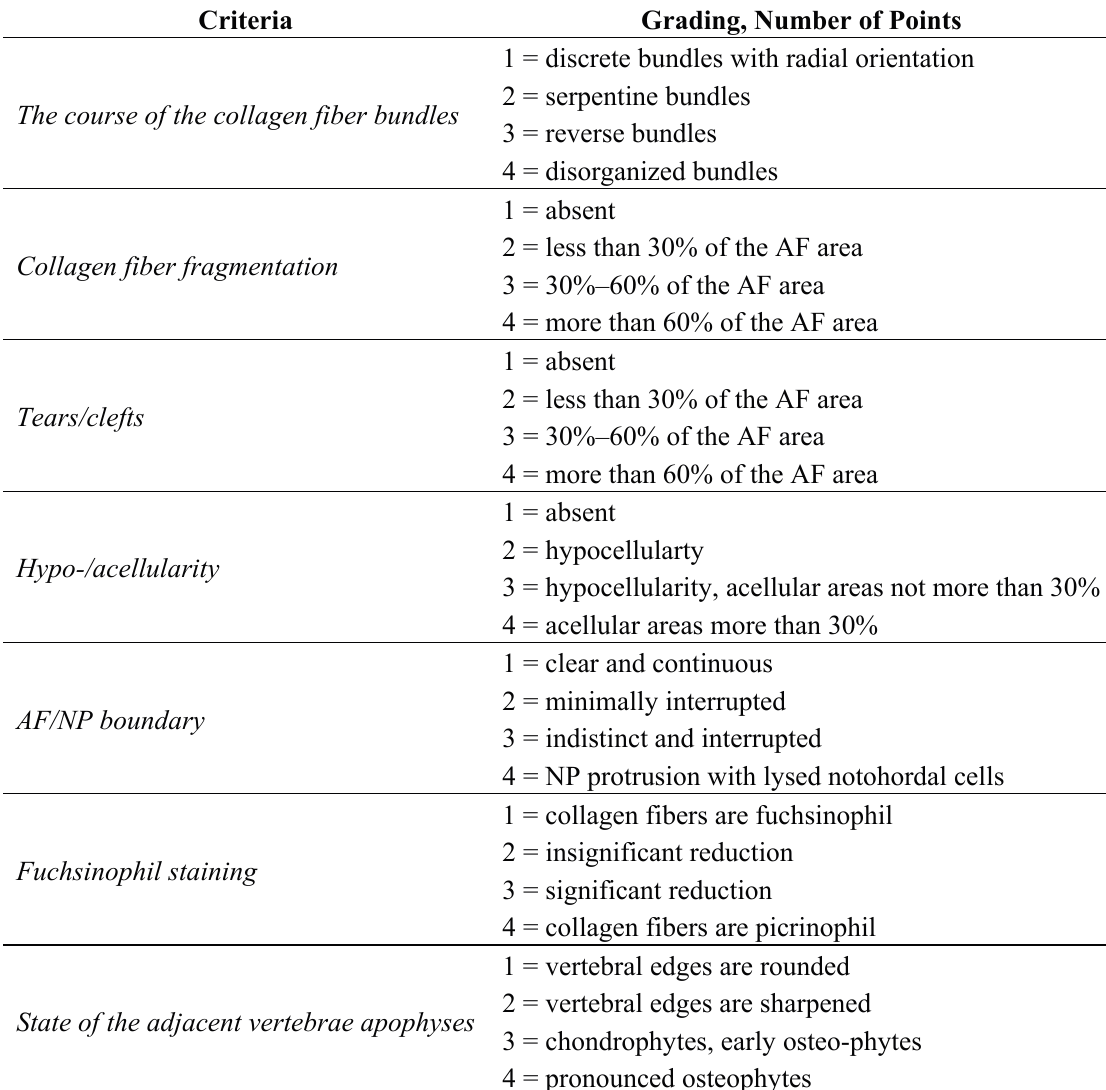
Table 1. Integrated semi-quantitative histological analysis of the AF